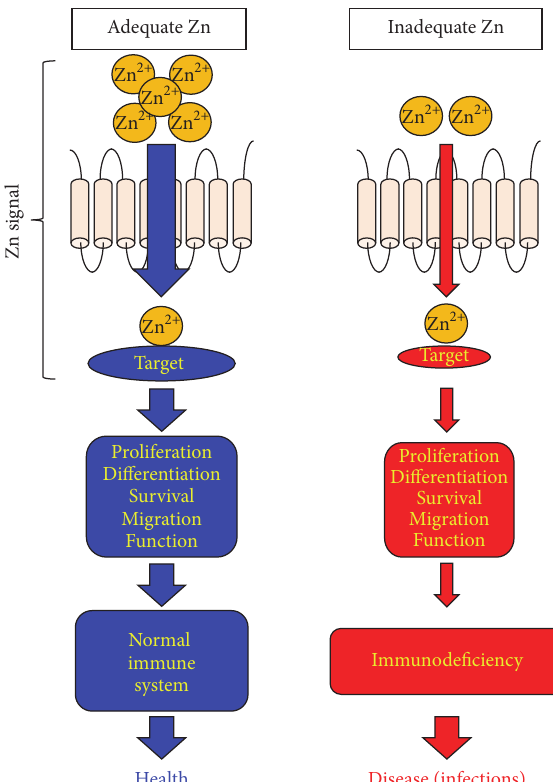
Figure 7: Zn-signal axes in immune system. Each Zn-signal axis targets a specific molecule and controls a variety of cellular activities such as proliferation, differentiation, survival, migration, and function via a distinct signaling pathway to control immune homeostasis and functions. ZnD (red) impairs these Zn-signal axes and leads to disease if there is no redundant